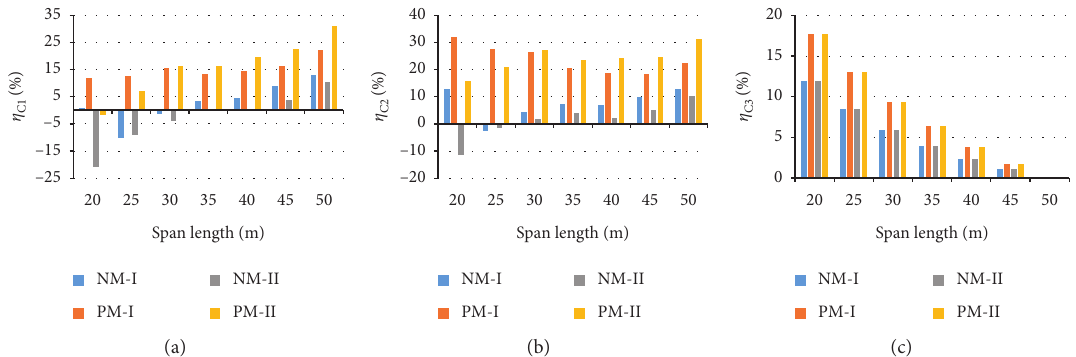
Figure 10: Comparison of the traffic loading effects of four-span continuous girder bridges without the dynamic load allowance: (a) η (b) η C2 ; (c) η C3